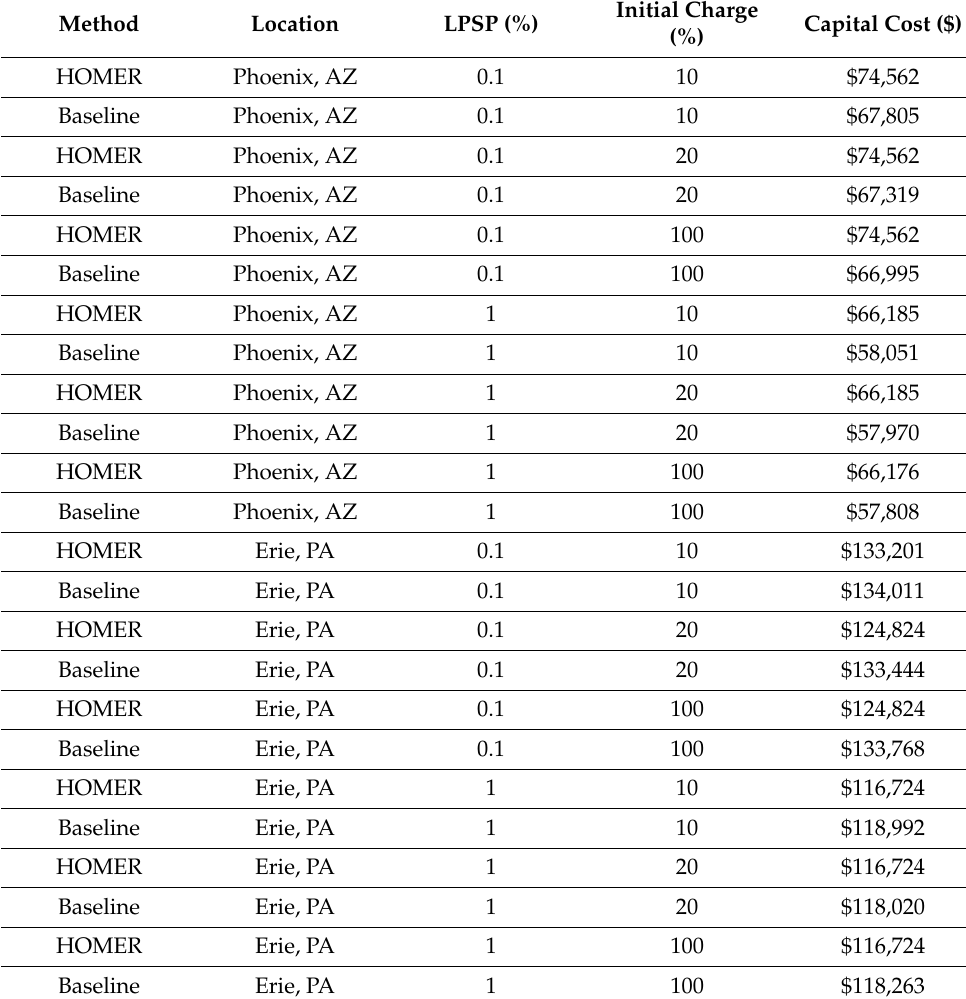
Table 3. Validation of sizing model using HOMER